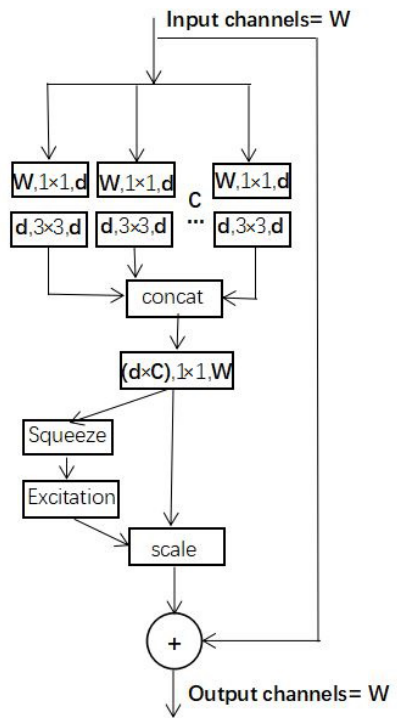
Figure 6. Structure of Squeeze-and-Excitation net (SEnet). The yellow arrow represents the squeeze stage, the blue arrow represents the scale stage, and the green arrow represents the excitation stage.